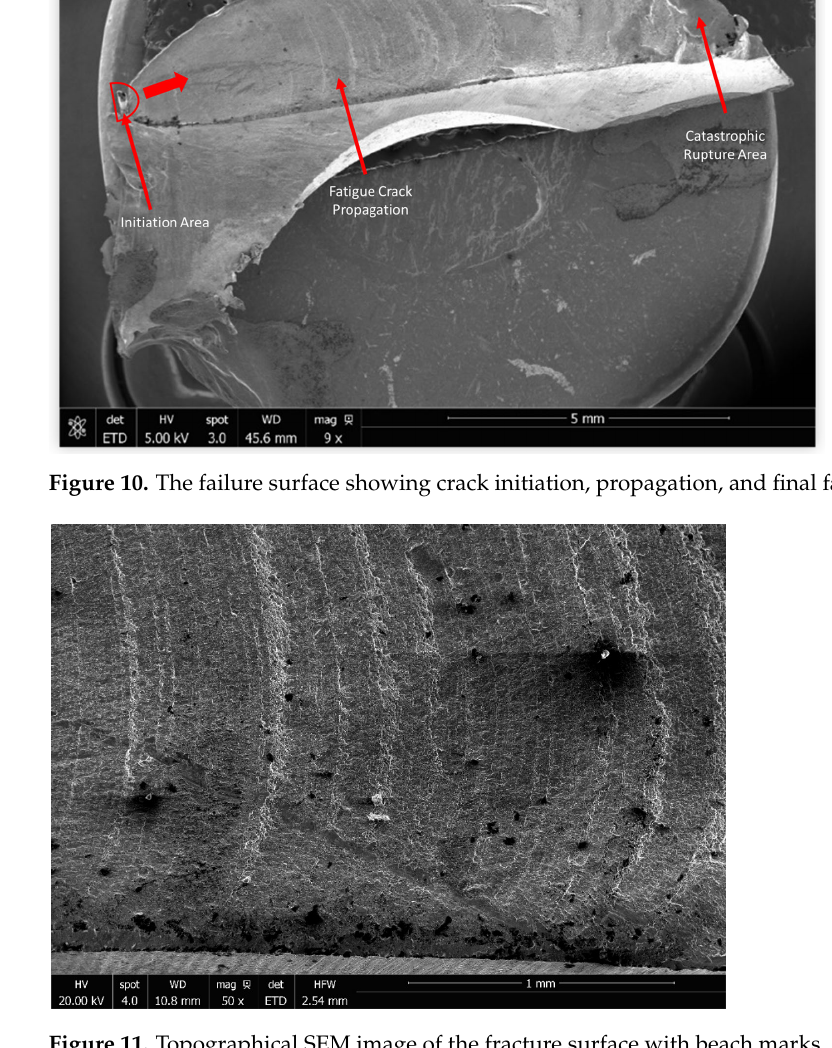
Figure 13. Topographical SEM image of the fracture initiation area.